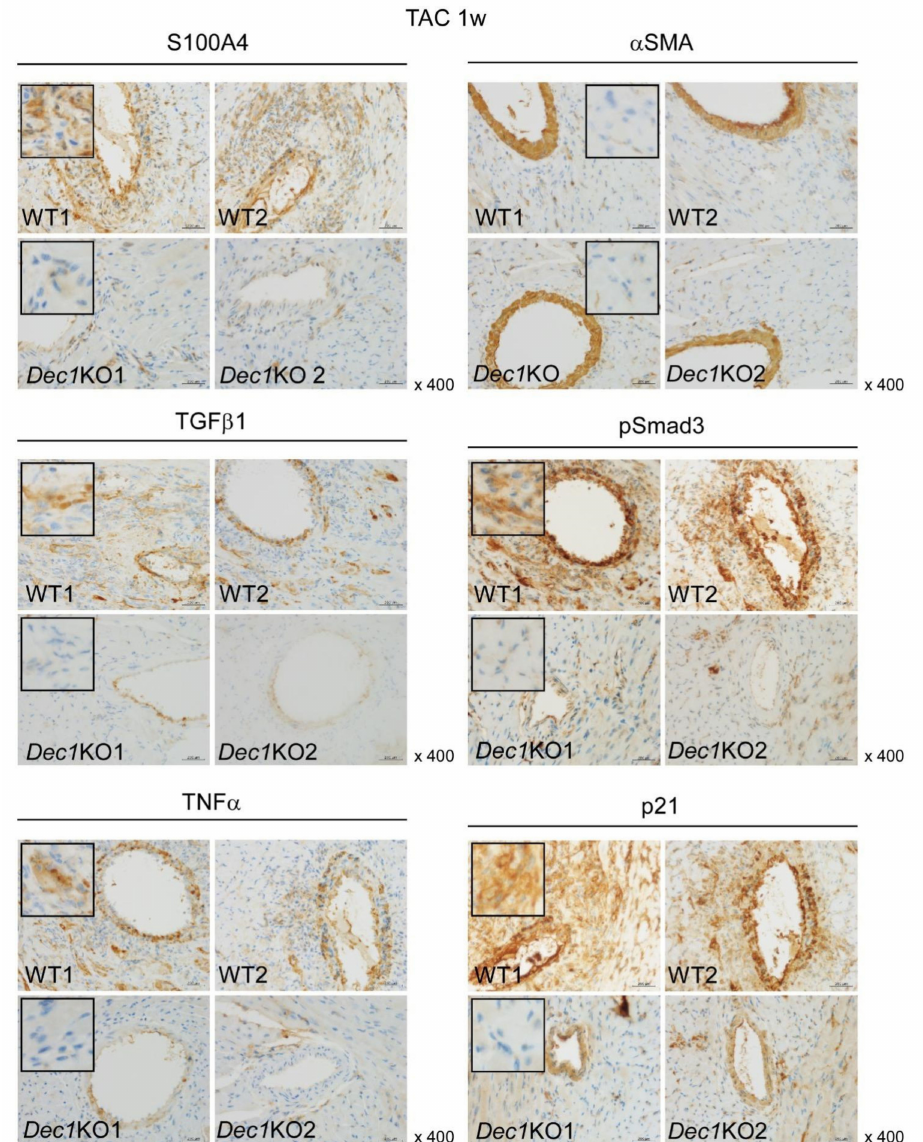
Figure 4. Dec1 deficiency suppresses the expression of S100 calcium binding protein A4 (S100A4), transforming growth factor beta 1 (TGF β 1), phosphorylation of Smad family member 3 (pSmad3), tumor necrosis factor alpha (TNF α ), and cyclin-interacting protein 1 (p21) at one week after TAC. Immunohistochemical detection of S100A4, alpha smooth muscle actin ( α SMA), TGF β 1, pSmad3, TNF α , and p21 in cardiac perivascular lesions. Representative images of two independent WT (WT1, WT2) and Dec1 KO ( Dec1 KO1, Dec1 KO2) mice at one week after TAC. Magnification 400 × . The black square was magnified from a representative